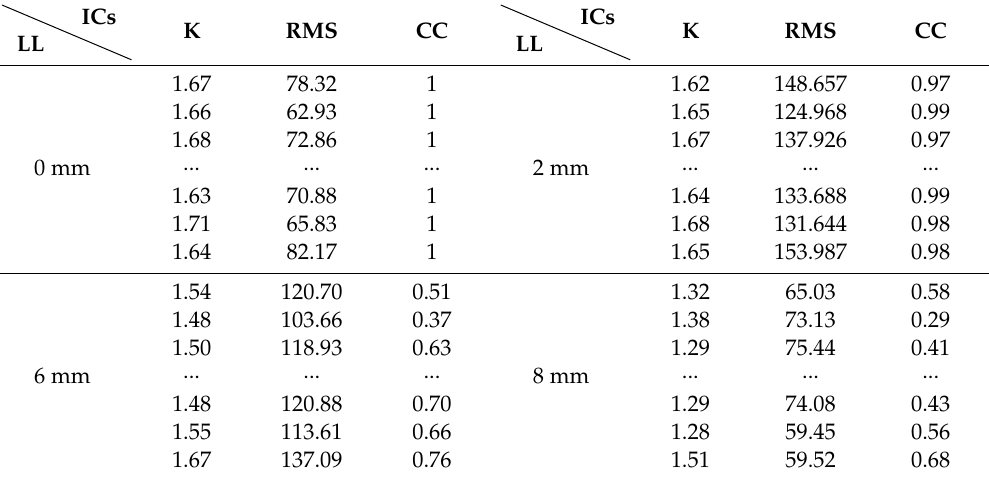
Table 1. Excitation condition indicators (CIs).